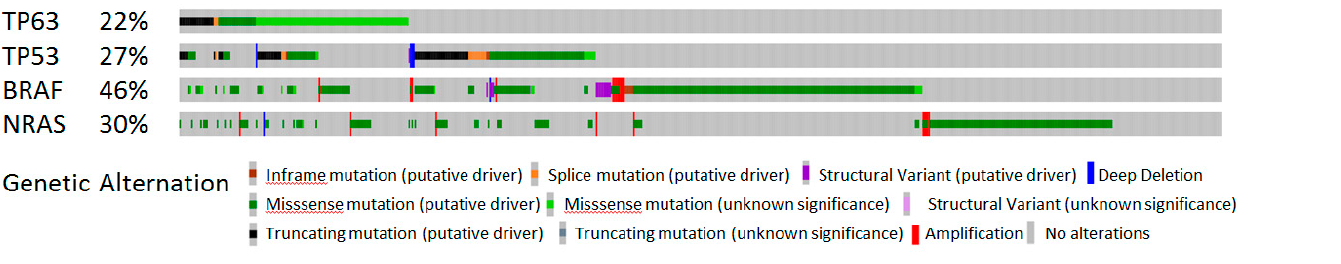
Figure 2. Genetic alterations of TP53 , TP63 , BRAF, and NRAS in 696 melanoma patients/samples (downloaded data from cBioPortal Oncoprint view, https://www.cbioportal.org/, accessed on 27 October 2022) [56–58].